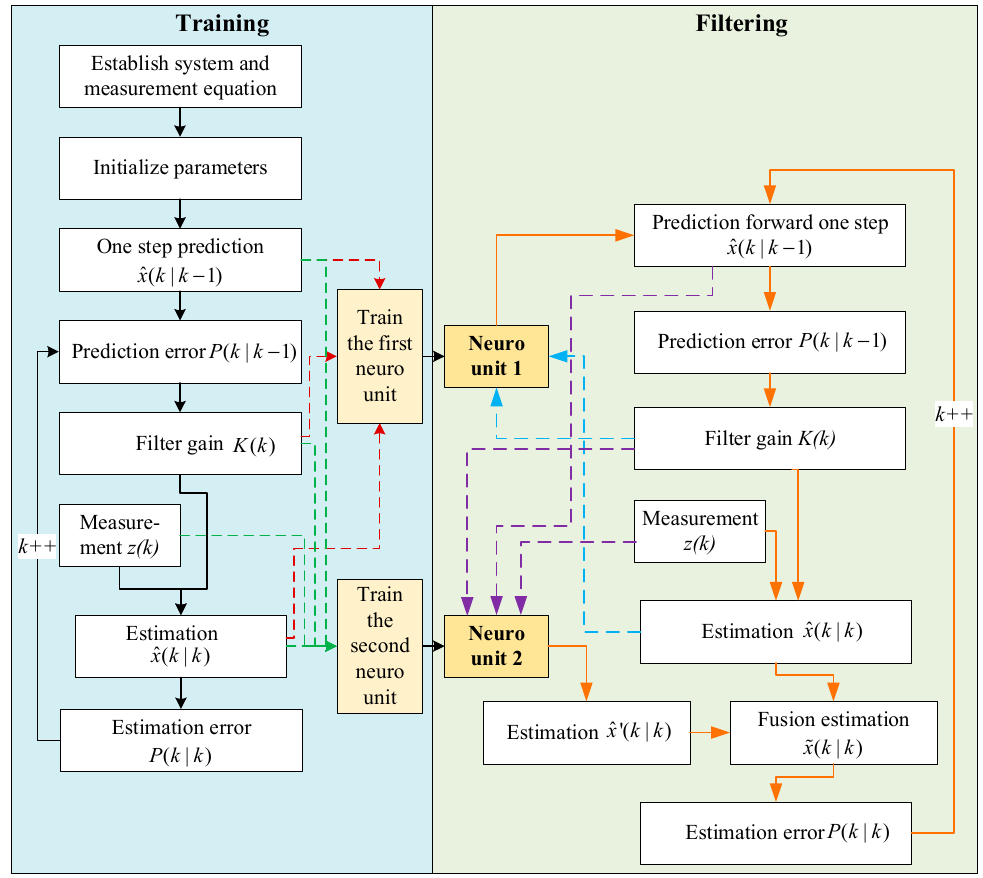
Figure 4. Algorithm flow of the adaptive filtering with the neuron-based Kalman filter.